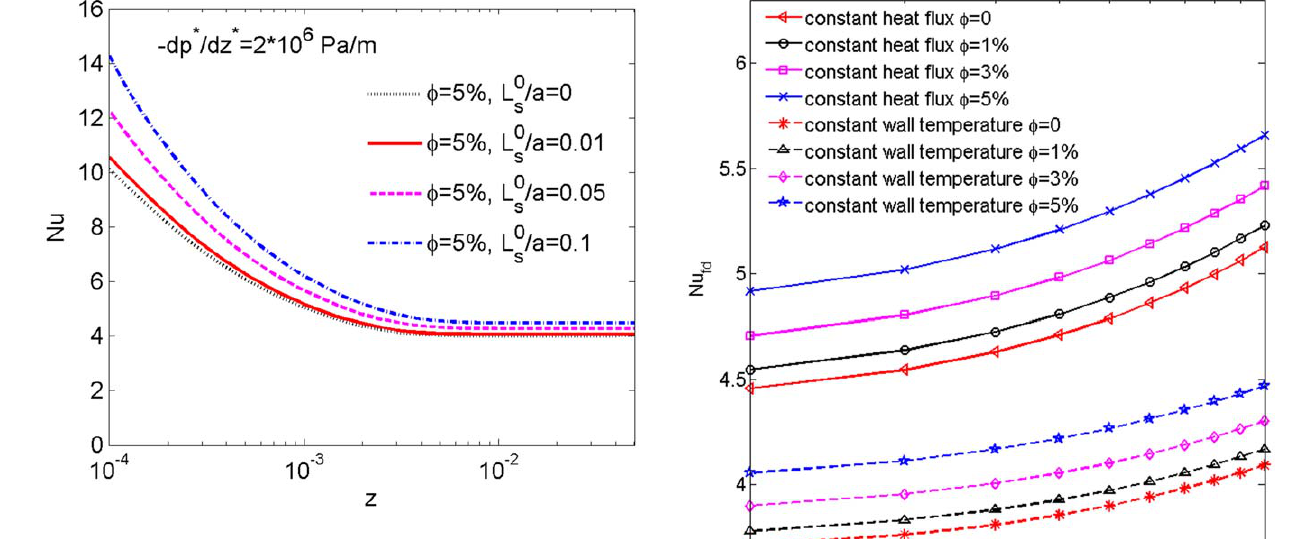
Figure 7. The heat transfer rates corresponding to different boundary slip lengths. Comparison of the heat transfer curves for L 0 = a ~ 0, 0.01, 0.05 and 0.1 with a fixed nanoparticle volume fraction s w ~ 5% and pressure gradient { dp (cid:2) = dz (cid:2) ~ 2 | 10 6 Pa/m, showing the effect of slip length on the heat transfer rate. doi:10.1371/journal.pone.0037274.g007 Figure 8. The thermally fully developed heat transfer rates for